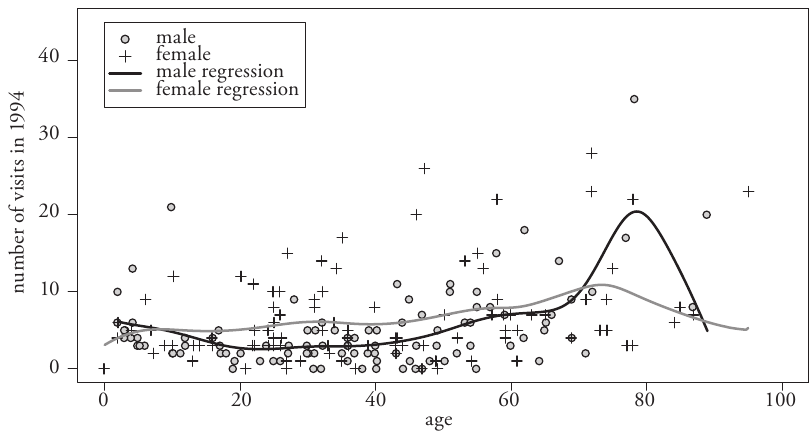
Figure 6: The number of visits to a GP against